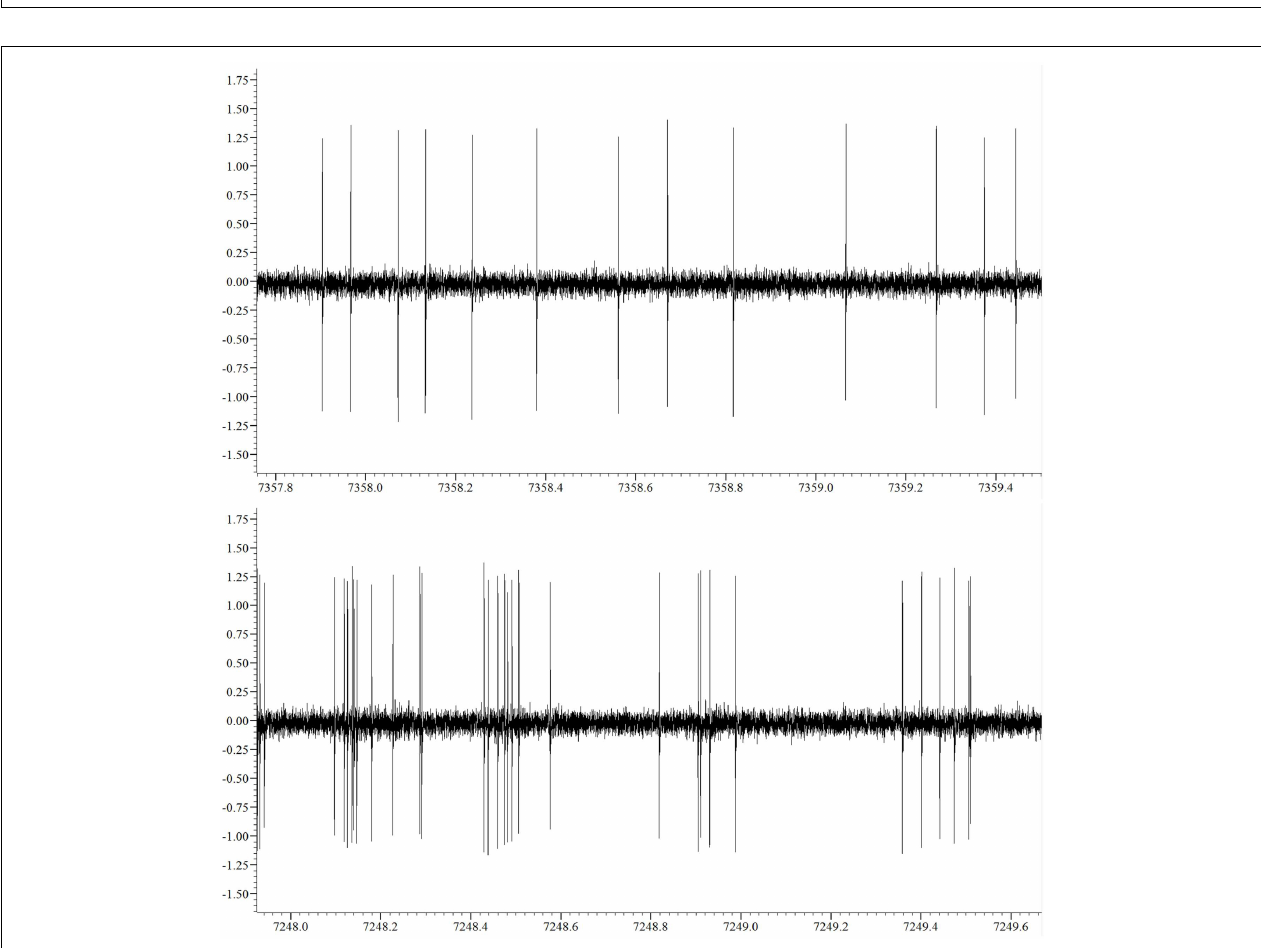
FIGURE 2 | Stereotactic coordinates of recording sites for 14 sample neurons .This figure is modified from Ref. (31) with permission.